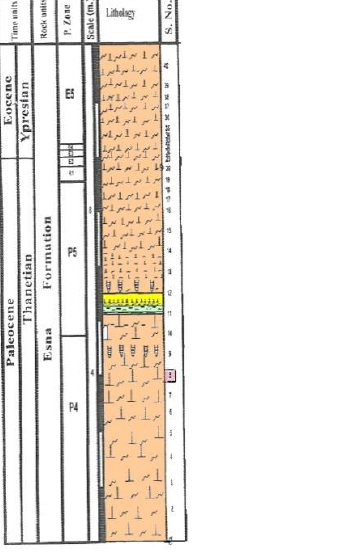
Figure 5: The stratigraphic position of sample 8 of the holotype of Lenticuzonaria misrensis Anan, n. sp. from the Late Paleocene of Qreiya section Central Egypt (Youssef & Taha,